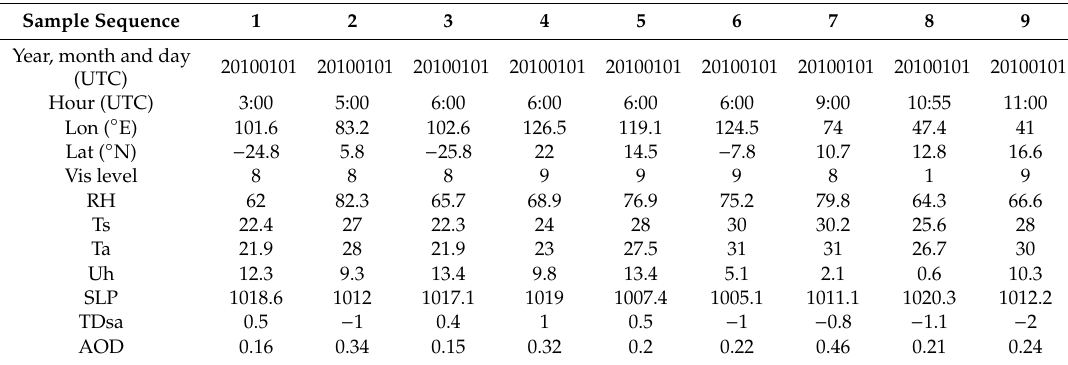
Table 2. The sample data set to train the model for both fog and